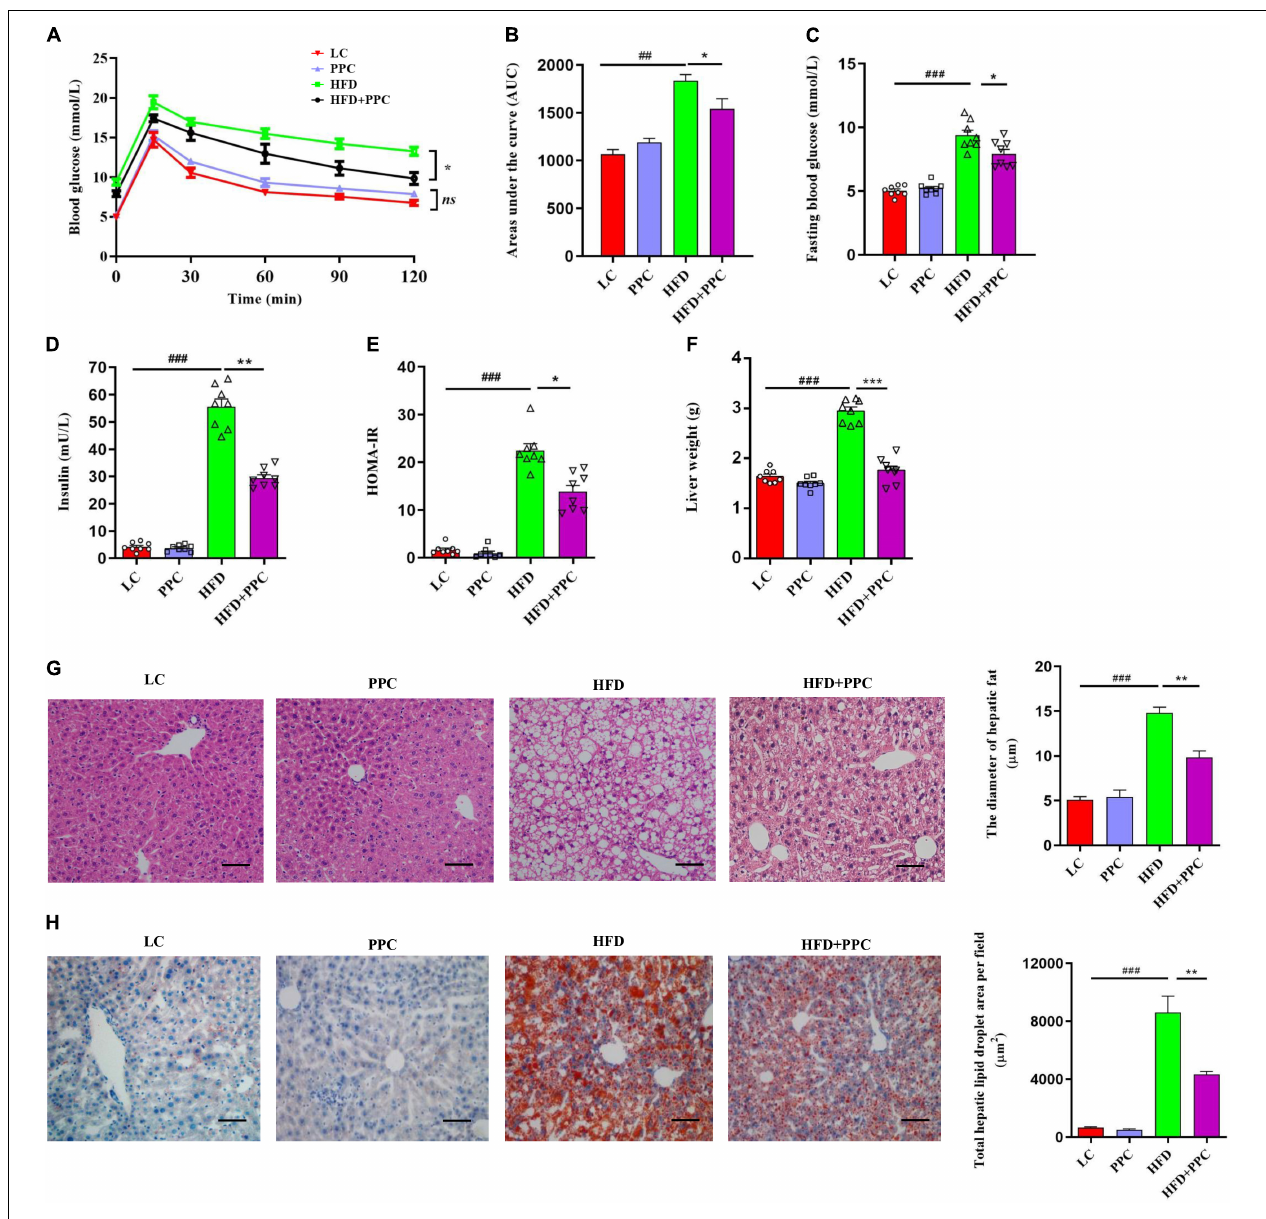
FIGURE 2 | PPC supplementation improves insulin sensitivity and alleviates liver steatosis in the mice fed by HFD. (A) Glycemia changes in every 30 min. (B) AUC for GTT. (C) Fasting glycemia. (D) Blood insulin. (E) HOMA-IR. (F) The mass of liver. (G) Representative liver images and statistical analysis of H&E staining. (H) Representative liver images and statistical analysis of oil red staining. The scale bar is 50 µ m. n = 8 mice for each group. The differences were analyzed using ANOVA. Data represent means with SEM. The pound signs indicate statistically significant differences compared to the LC group. # P < 0.05, ## P < 0.01, ### P < 0.001. Asterisks indicate statistically significant differences compared to the HFD group. * P < 0.05, ** P < 0.01, *** P < 0.001. ns, no